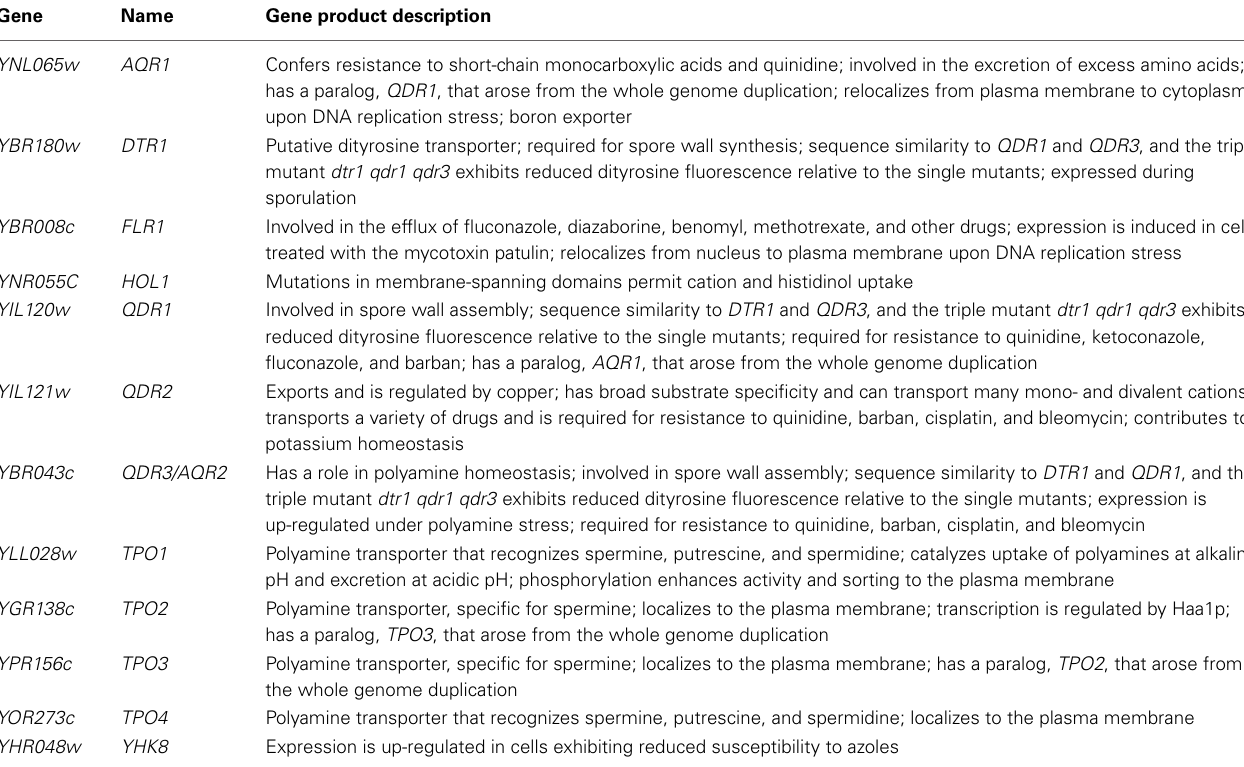
Table 1 | List of MDR/MXR-MFS transporters encoded in the genome of S. cerevisiae , belonging to the DHA1 family, gene product descriptions are based on the information listed for each gene in the Saccharomyces Genome Database.